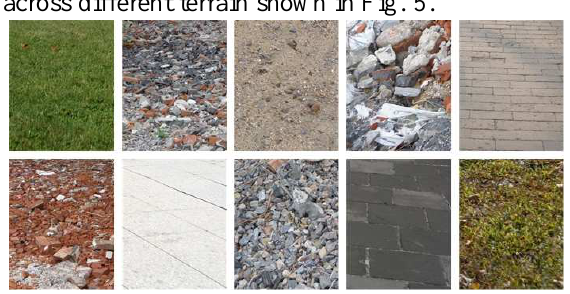
Fig. 5. The part types of training terrain in experiments.